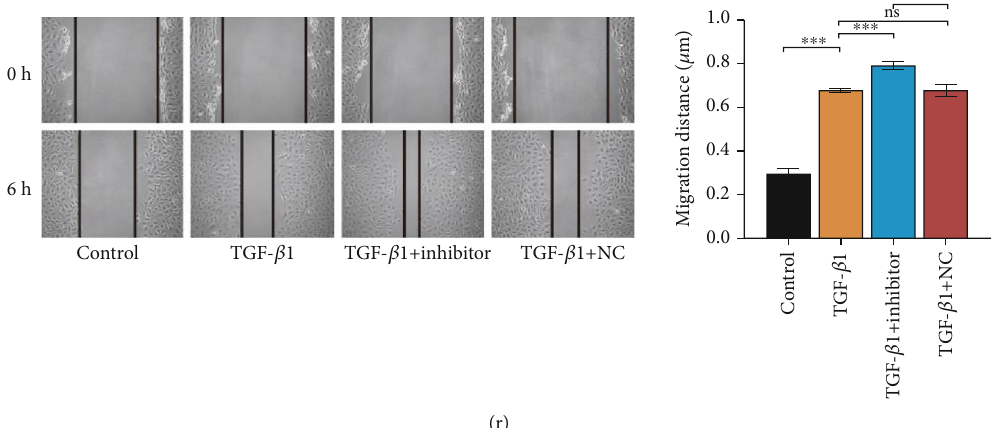
Figure 6: miR-450a-2-3p inhibits TGF- β 1-induced EMT of HUVECs induced by TGF- β 1. miR-450a-2-3p, VE-Cad, CD31, vimentin, COL1, and COL3 mRNA levels in HUVECs transfected with mimics (a) – (f) and inhibitor (g) – (l) were determined via RT-qPCR. The protein levels of VE-Cad, CD31, vimentin, COL1, and COL3 in CFs transfected with mimics (m) and inhibitor (n) were examined using western blot. Expression levels of miRNAs were normalized to that of U6, and the expression levels of mRNAs and proteins were normalized to that of actin. Representative images of VE-Cad immuno fl uorescence staining in HUVECs transfected with mimics (o) and inhibitor (p) ( × 200 magni fi cation) showed the anti fi brotic e ff ect of miR-450a-2-3p. Representative images of the scratch assay of mimic- (q) and inhibitor- transfected (r) HUVECs ( × 100 magni fi cation). Data is presented as the mean ± SEM of three independent experiments. ∗ P < 0 : 05 , ∗∗ P < 0 : 01 , ∗∗∗ P < 0 : 001 , ∗∗∗∗ P < 0 : 0001